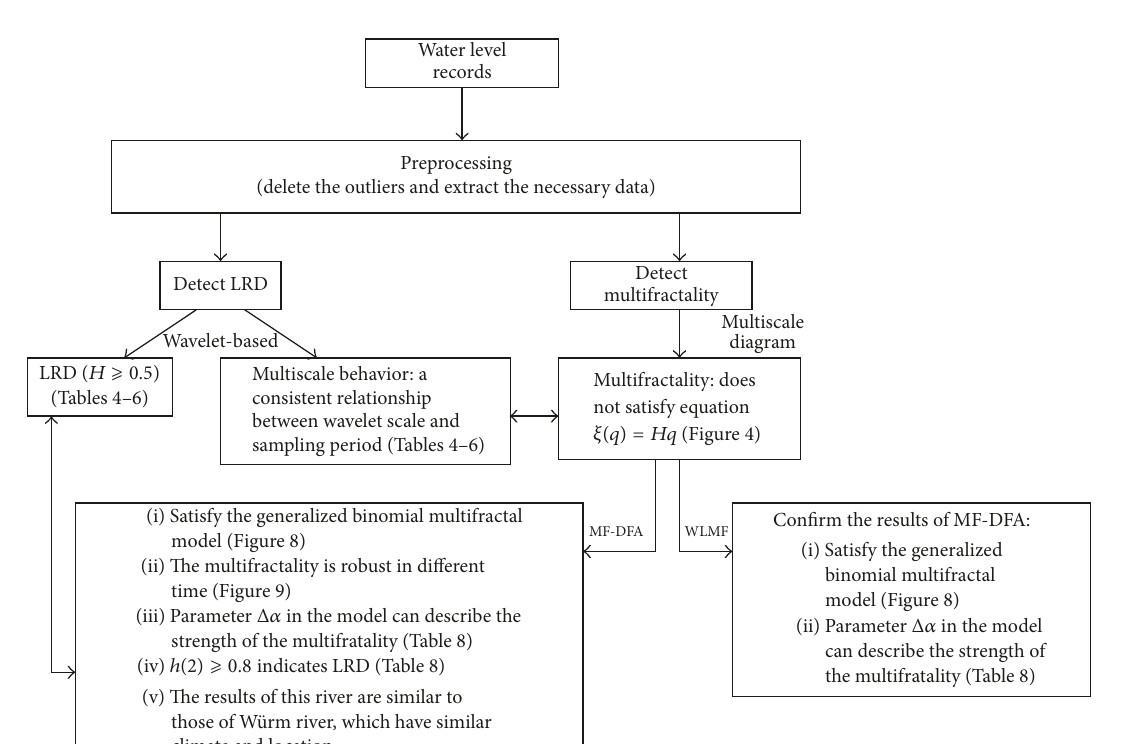
Figure 1: Data processing flow